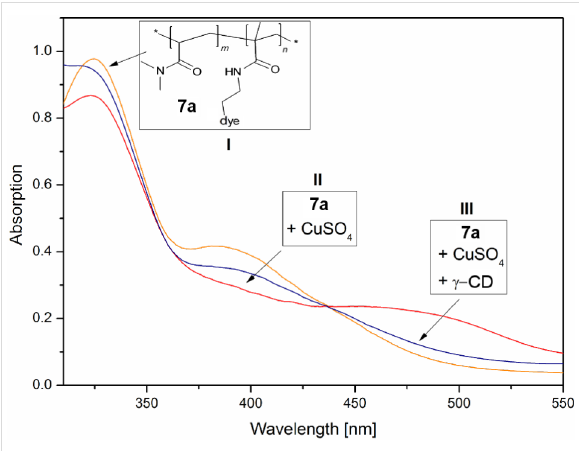
Figure 2: UV–vis absorption spectra of (orange) the solved copolymer 7 with the induced shifts by addition of (red) copper(II) sulfate and (blue) γ -CD in an aqueous methanol medium.